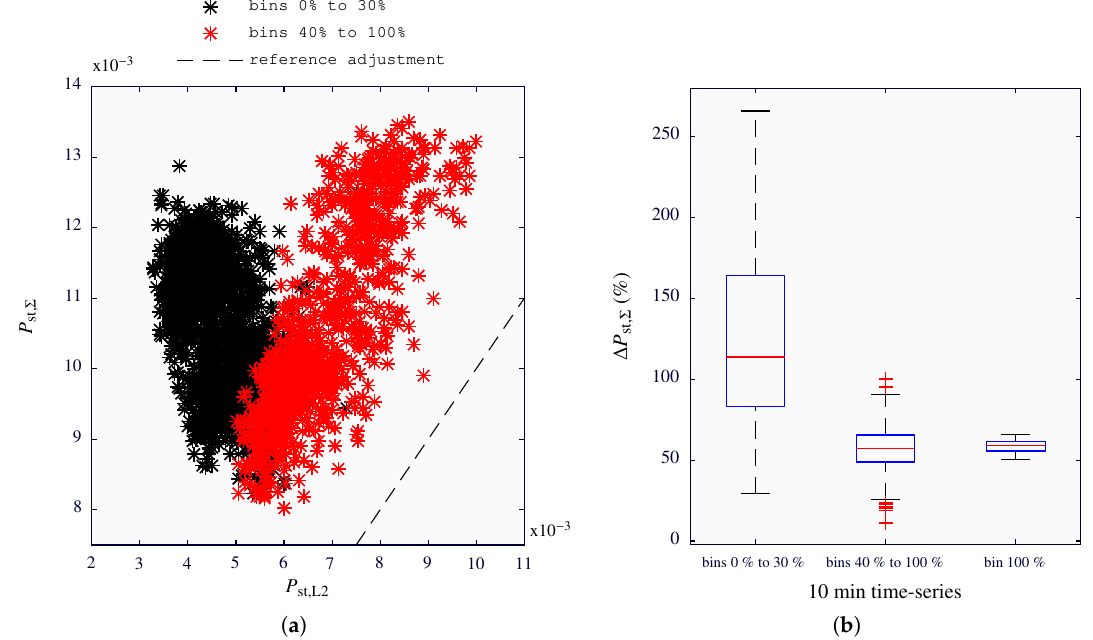
Figure 8. Deviation between the estimated P st, Σ and measured P st,L2 values at the PCC. ( a ) Estimated versus measured results, obtained with the time series classified between the power bins 0% to 30% (in black) and between 40% to 100% (in red). ( b ) Boxplots of the percentage deviation between the estimated P st, Σ and the measured P st,L2